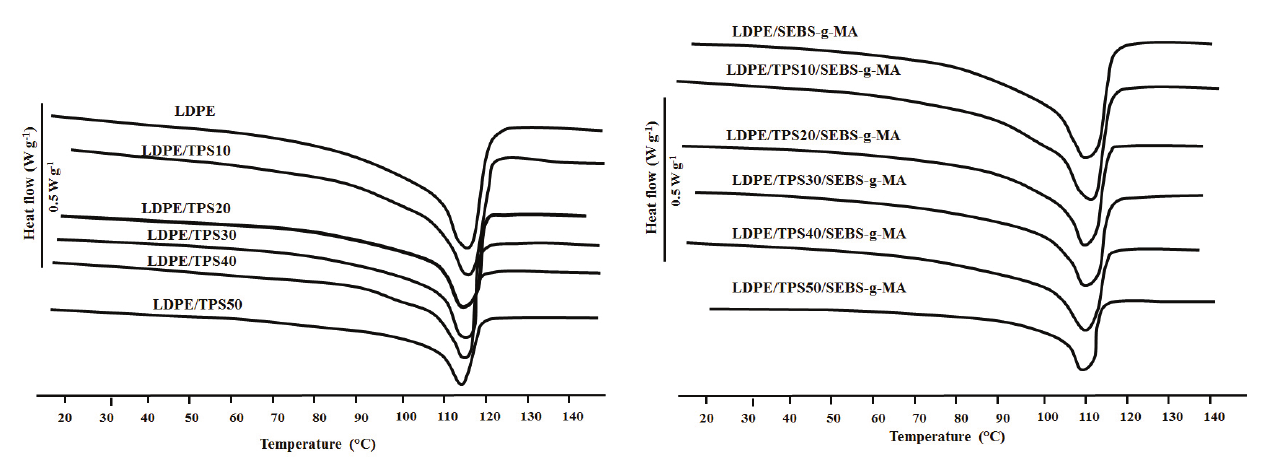
Fig. 2 – DSC heating thermograms of LDPE/TPS blends